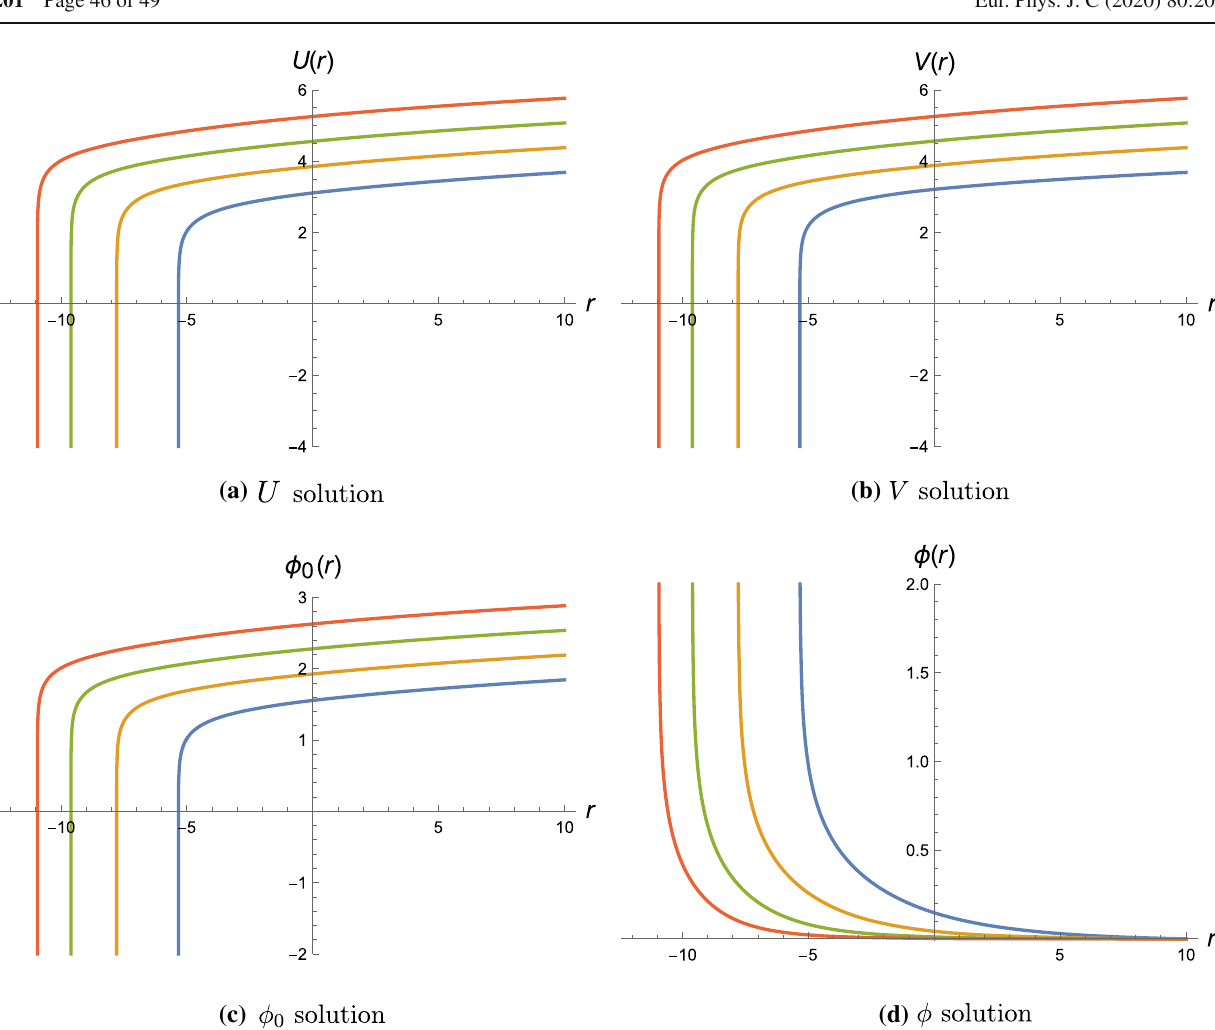
Fig. 46 Supersymmetric flows interpolating between asymptotically locally flat domain walls and Mk w 2 × CH 2 -sliced curved domain walls in SO ( 4 ) gauge group. The blue, orange, green and red curves refer to g = 4 , 8 , 16 , 32, respectively